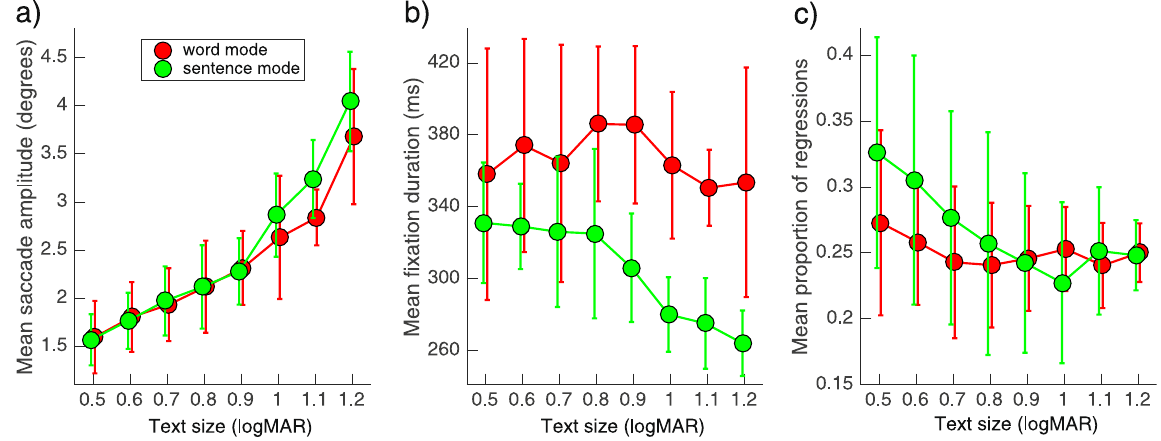
Figure 6. Saccadic amplitude (panel a), fixation duration (panel b) and proportion of eye movement regressions (panel c) plotted as a function of text size from 0.5 to 1.2 logMAR. The symbols show the mean across four observers for both Word Mode (red circles) and Sentence Mode (green circles). The vertical error bars ( ± 84% CI) represent inter-observer